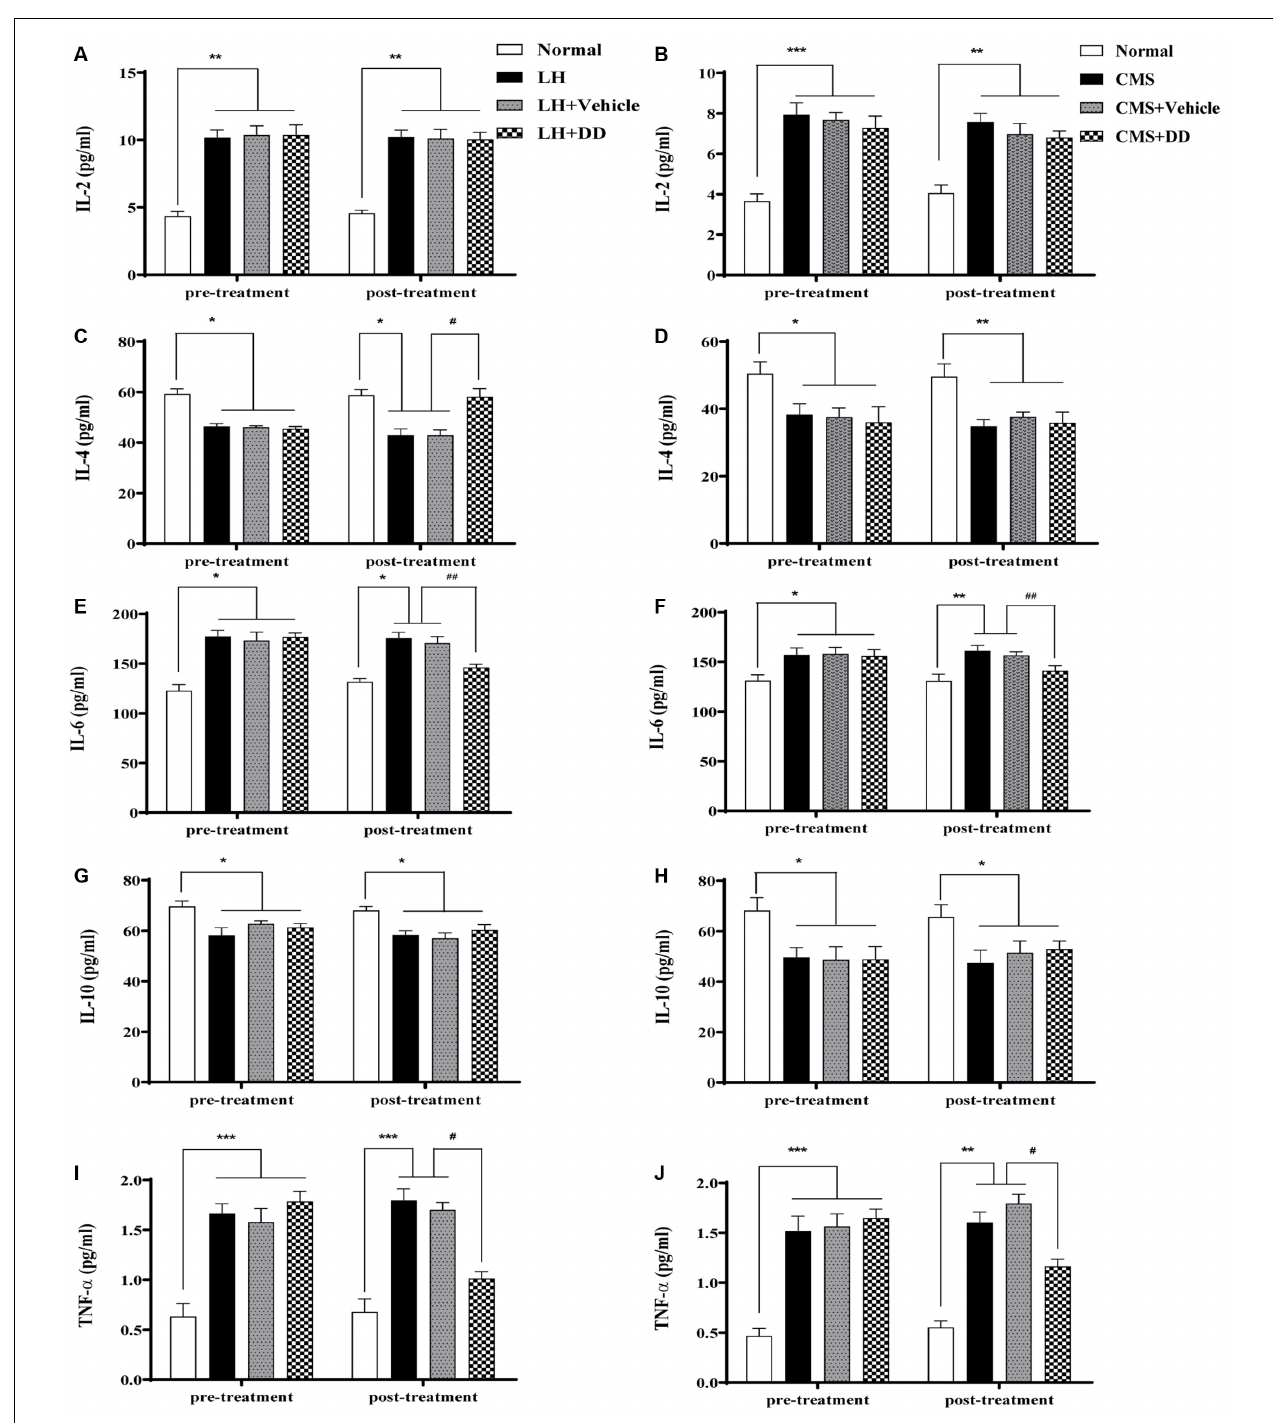
FIGURE 5 | Sub-chronic or chronic daidzein treatment rectified stress-induced imbalances of circulating cytokines. (A,C,E,G,I) LH model produced a significant imbalance in serum circulating cytokines, which involved upregulation of interleukin (IL)-2 and IL-6, and downregulation of IL-4, IL-10, and tumor necrosis factor (TNF)- α compared with the normal group. After sub-chronic treatment with DD, IL-4 was significantly increased, while IL-6 and TNF- α were also significantly reduced compared with the LH level, whereas no significant change in IL-2 and IL-10 levels was observed compared with the LH model rats. (B,D,F,H,J) Likely, CMS produced significant upregulation of IL-2 and IL-6, and downregulation of IL-4, IL-10, and TNF- α compared with the normal group. After chronic treatment with DD, IL-6 and TNF- α were significantly reduced compared with the CMS group, no significant change in IL-2 level was observed; IL-4 and IL-10 were slightly increased towards the normal level compared with CMS group. * p < 0.05, ** p < 0.01, *** p < 0.01, # p < 0.05, ## p < 0.01.